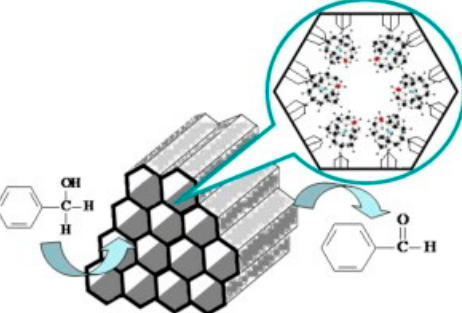
Figure 41. Schematic representation of vanadium-substituted phosphotungstic acids immobilized on amine-functionalized mesoporous MCM-41. Reproduced with permission from [78]. Copyright 2014 Elsevier B.V.